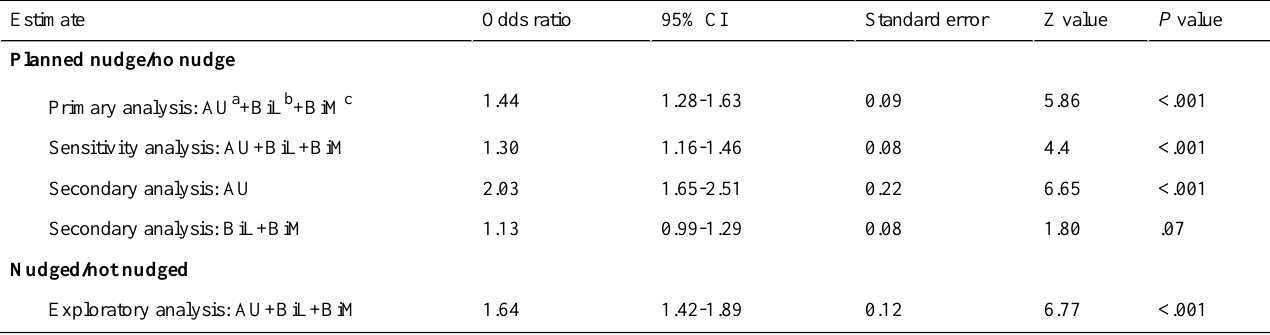
P valueZ valueStandard error95% CIOdds ratioEstimate